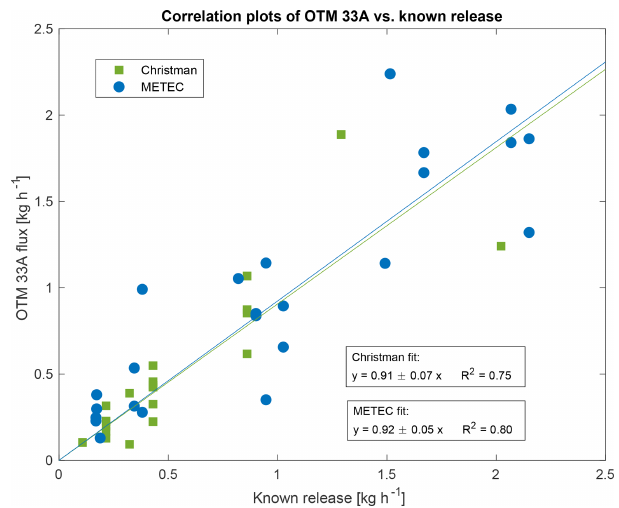
Figure 6. Correlation plot of OTM 33A-measured flux versus known release rates. Intercept is set to ( 0 , 0 )